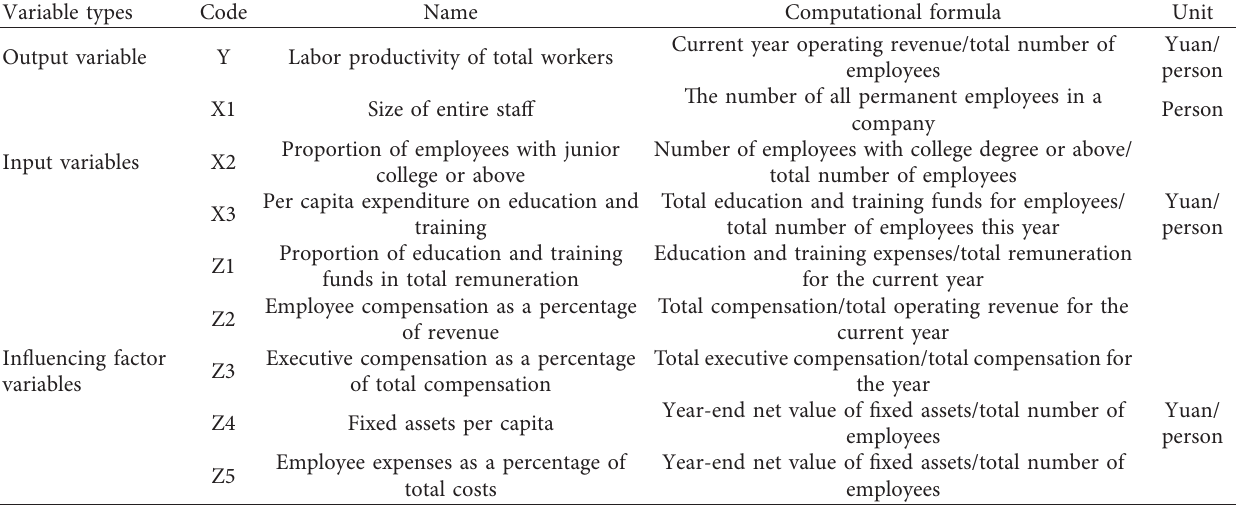
Table 1: Selection of variables for performance evaluation of tourism human resource